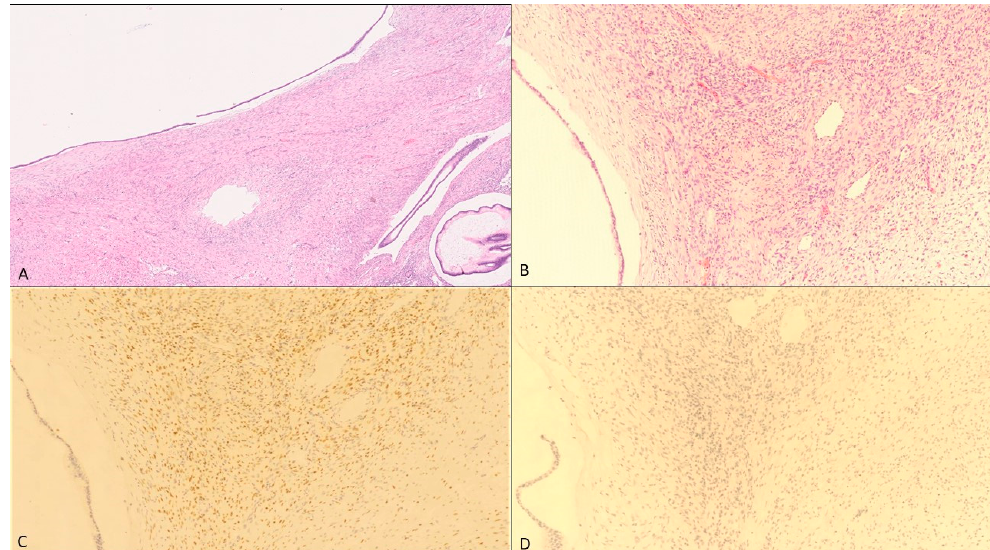
Figure 2. Pathological findings. ( A ) Cyst lined by mucinous epithelium (hematoxylin-eosin, 40×), ( B ) Ovarian-type stroma consists of spindle-shaped cells with round or elongated nuclei and sparse cytoplasm (hematoxylin-eosin, 200×), ( C ) Immunohistochemical staining with the expression of progesterone receptor (200×) and ( D ) with the negativity for estrogen receptor in the ovarian-type stroma (200×).